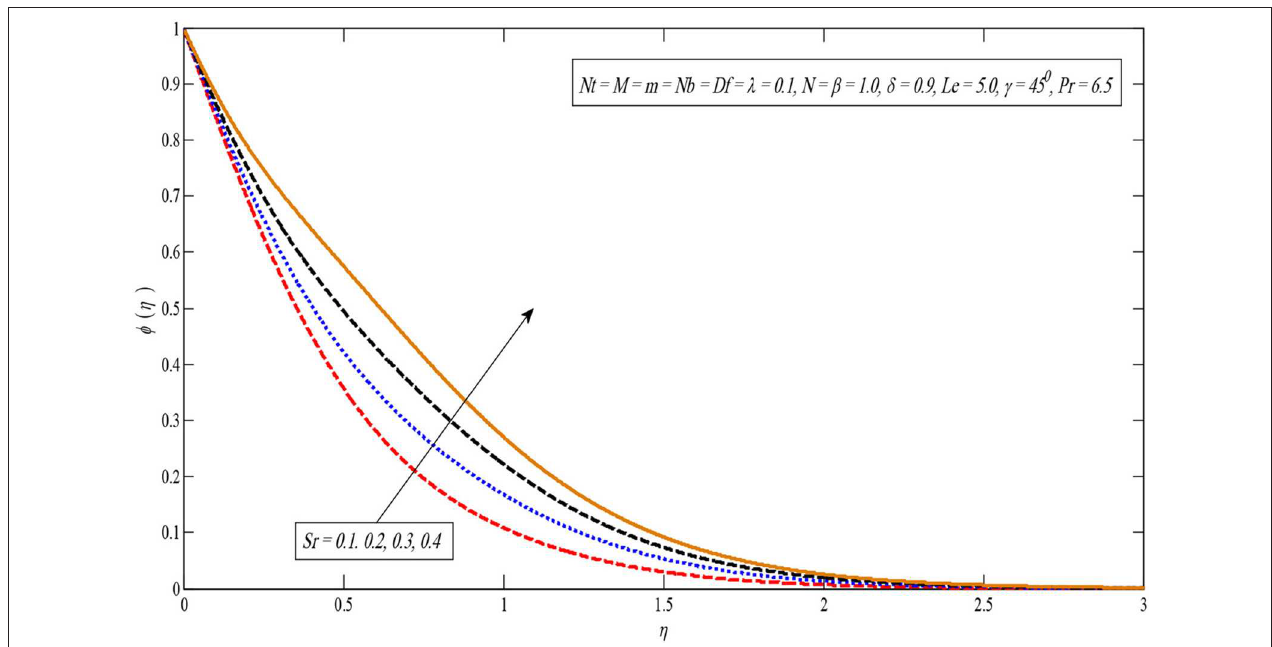
FIGURE 14 | Concentration profile for several values of Sr .